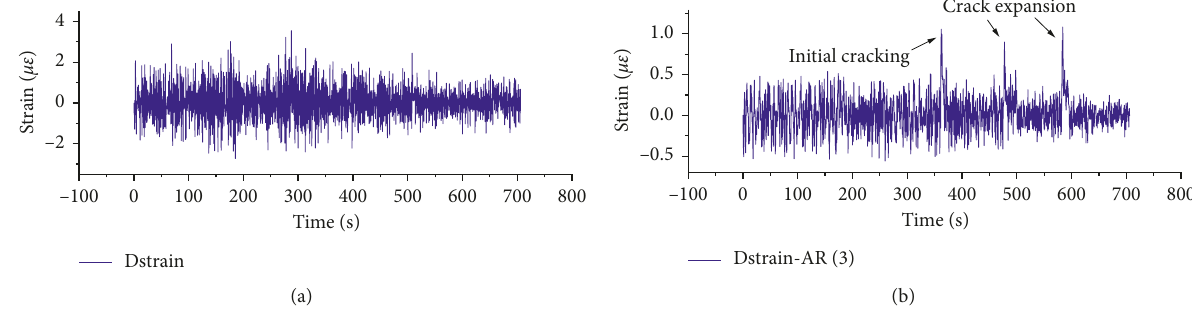
Figure 12: Strain time series: three FBG